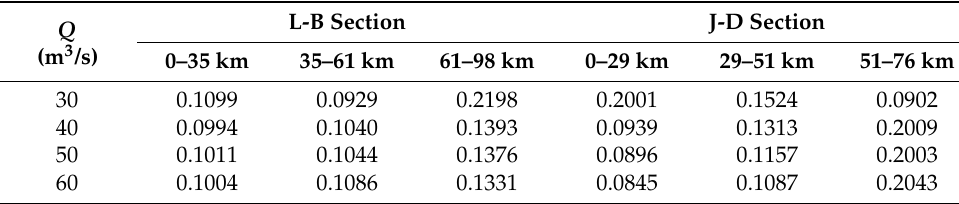
Table 10. Phenol degradation coefficient of L-B and J-D (Unit: d − 1